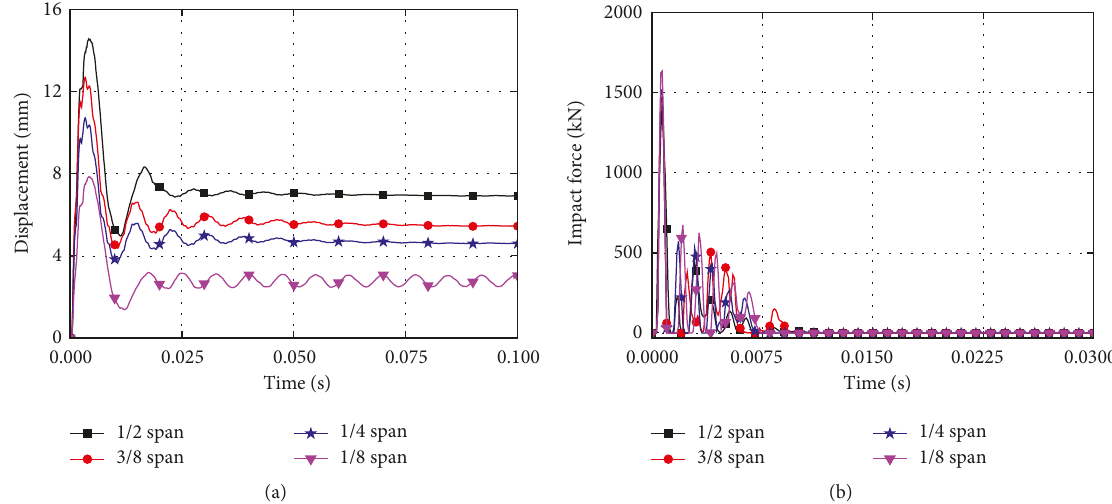
Figure 13: Comparison of impact response of different impact position. (a) Comparison of midspan displacement. (b) Comparison of impact